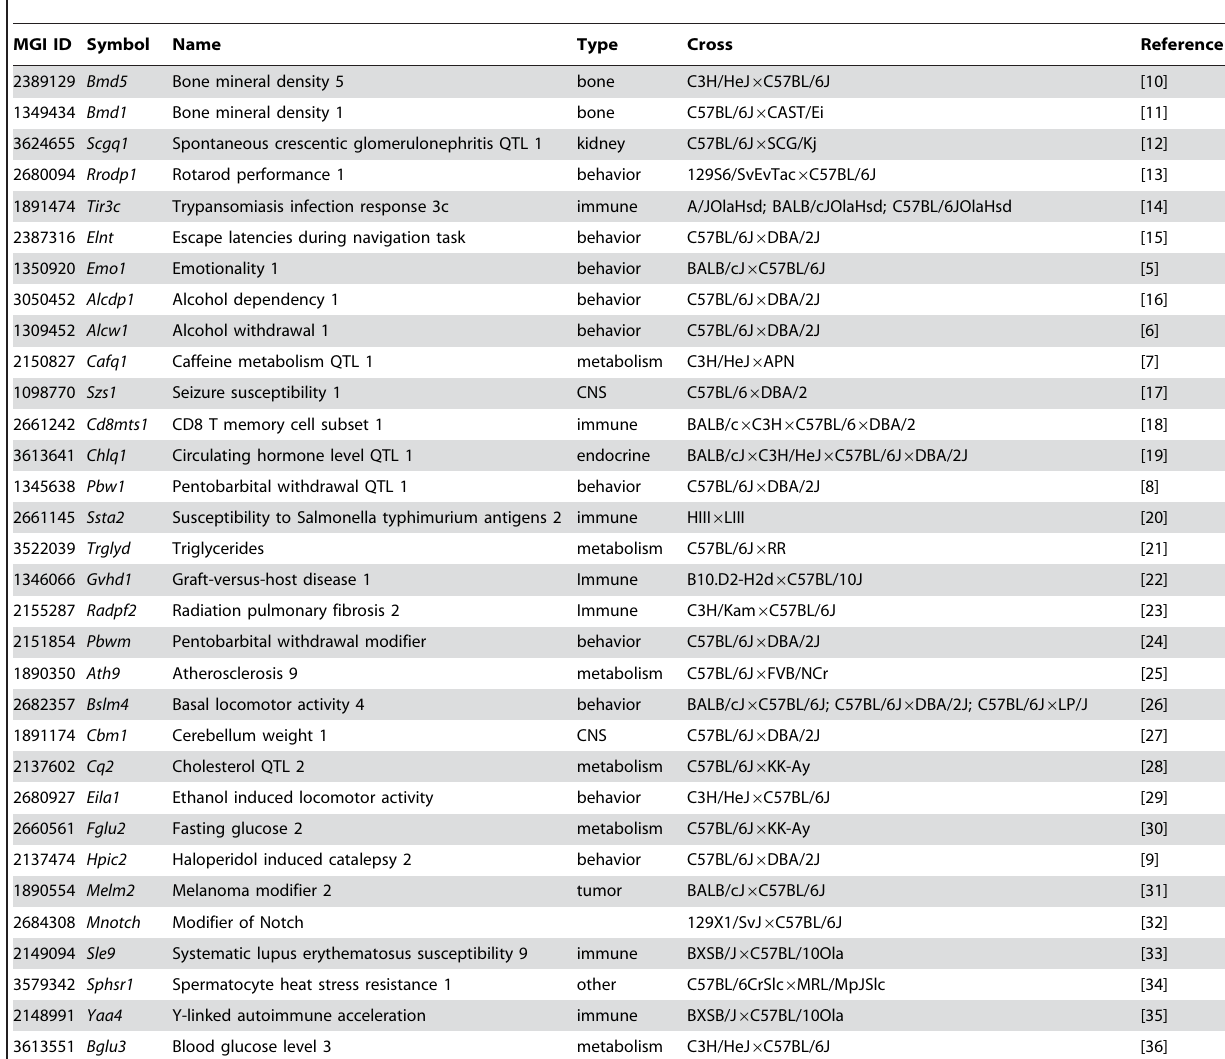
Table 1. Classical QTLs on Chr 1 from 172–178 Mb; listed by approximate position from proximal to distal end (adapted from Mouse Genome